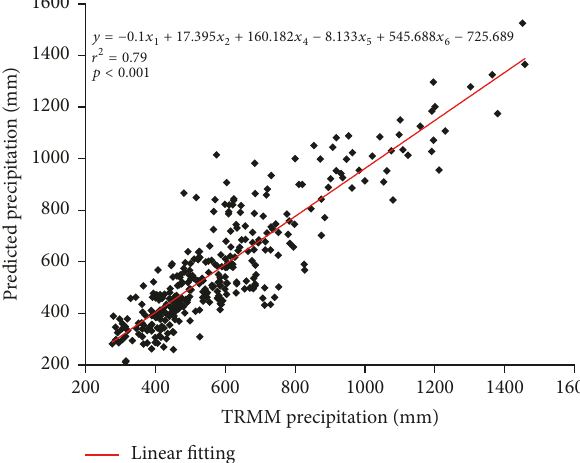
Figure 4: Scatter diagram of annual precipitation derived from TRMM 3B43 and that predicted by the OSR